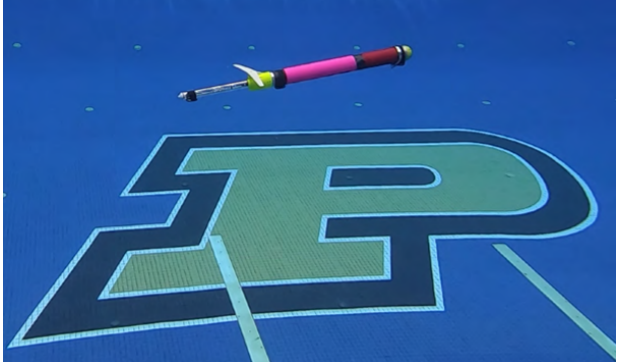
Figure 1. ROUGHIE surfacing during data collection. The magnetometer boom is visible at aft towards the left, with trim weights visible at the